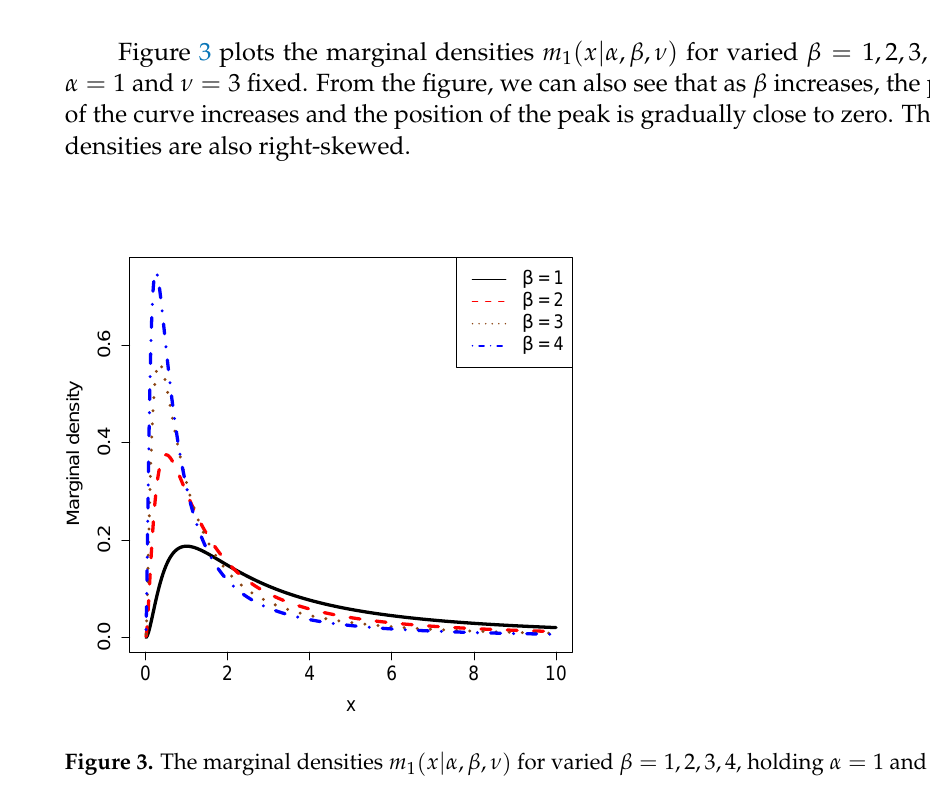
Figure 3. The marginal densities m 1 ( x | α , β , ν ) for varied β = 1,2,3,4, holding α = 1 and ν = 3 fixed.